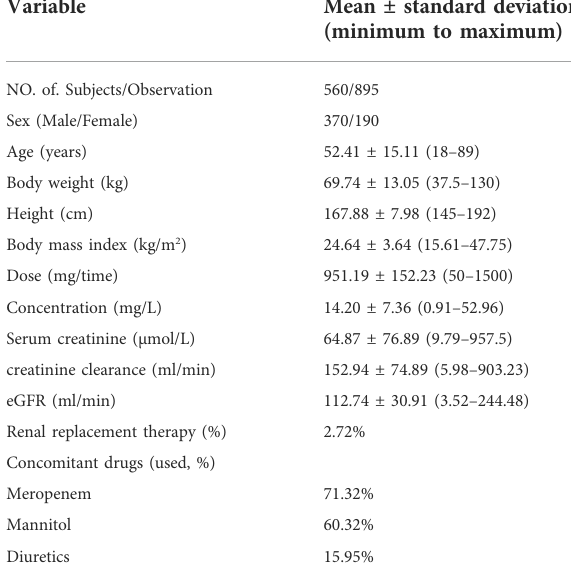
TABLE1Characteristicsofpatientsinthepopulationpharmacokinetic model of vancomycin. Variable Mean ± standard deviation (minimum to